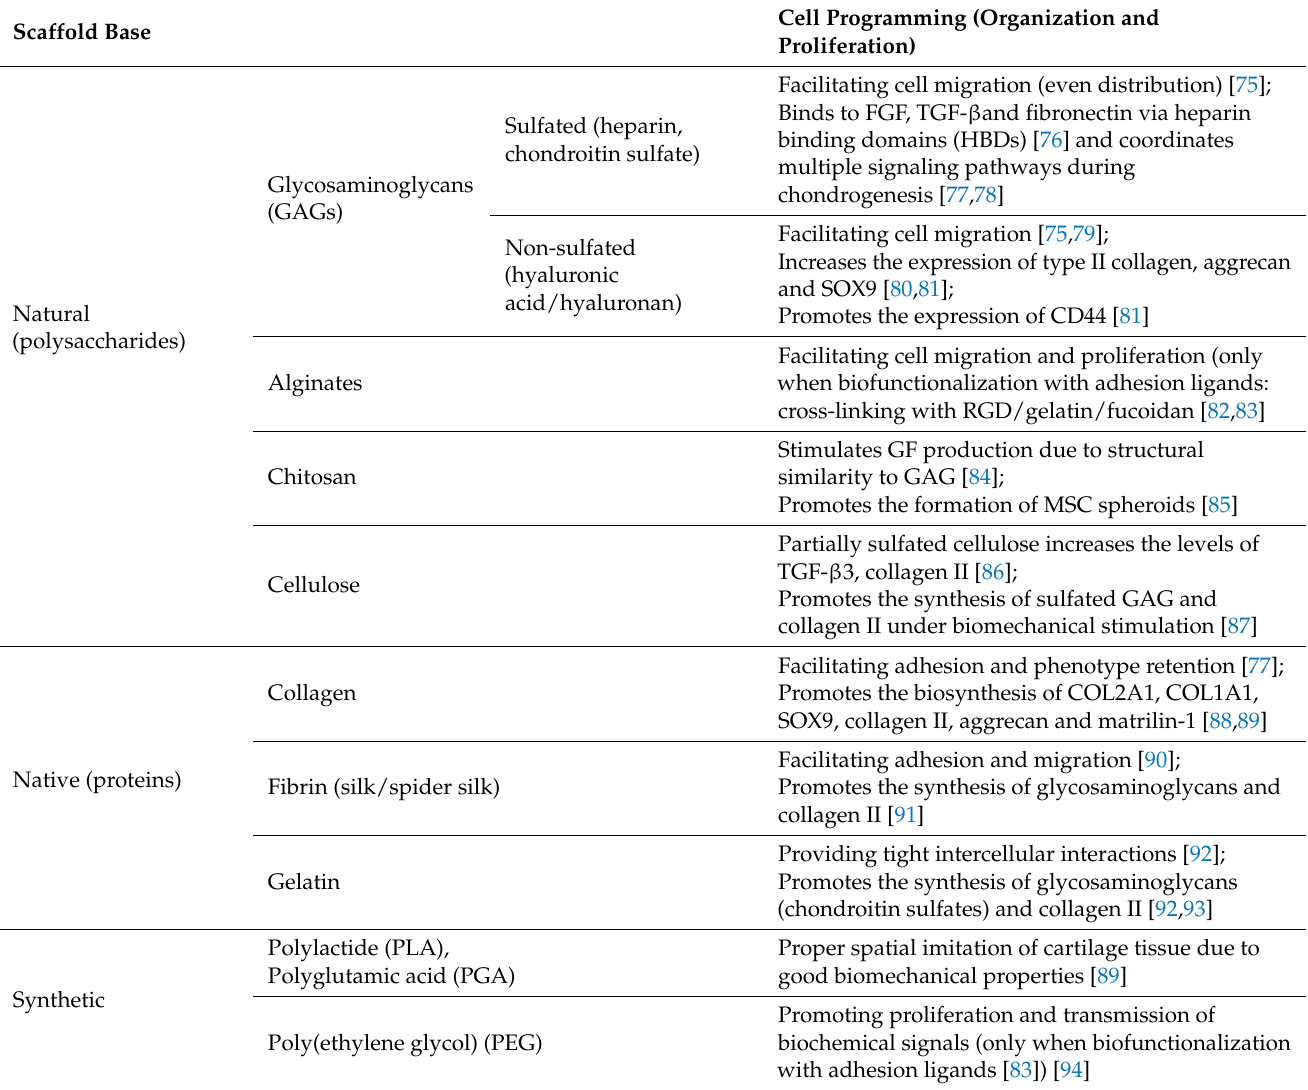
Table 2. Types of scaffold materials used in cartilage tissue engineering and their effect on MSC organization and proliferation. Scaffold